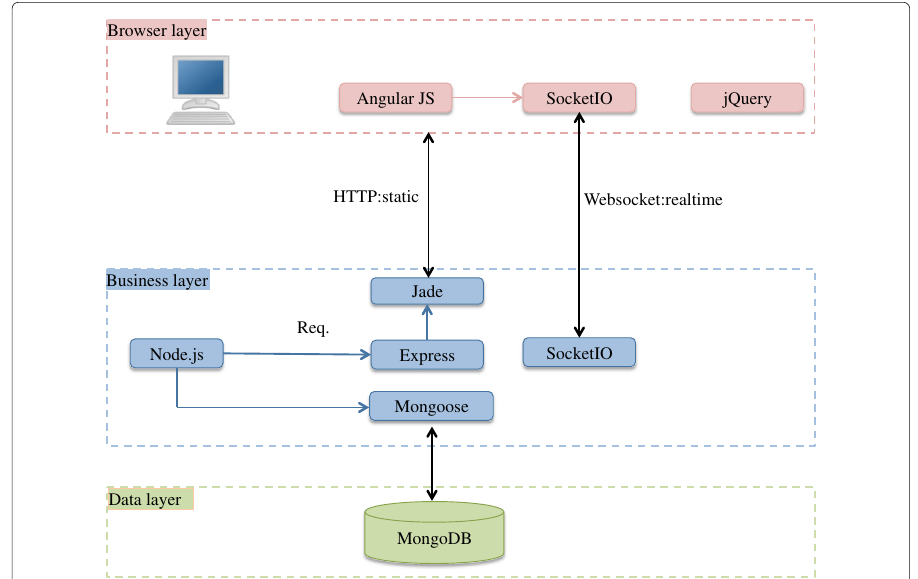
Fig. 2 Technology stack diagram of Multiscript